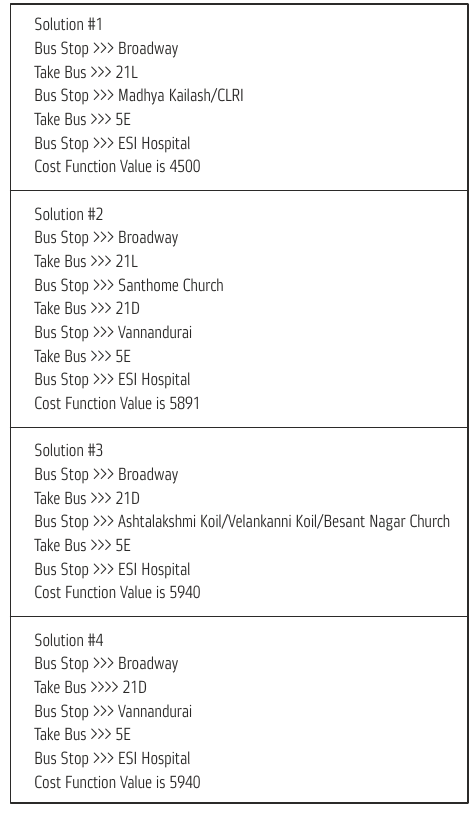
Figure 4. Program output for sample query: static case